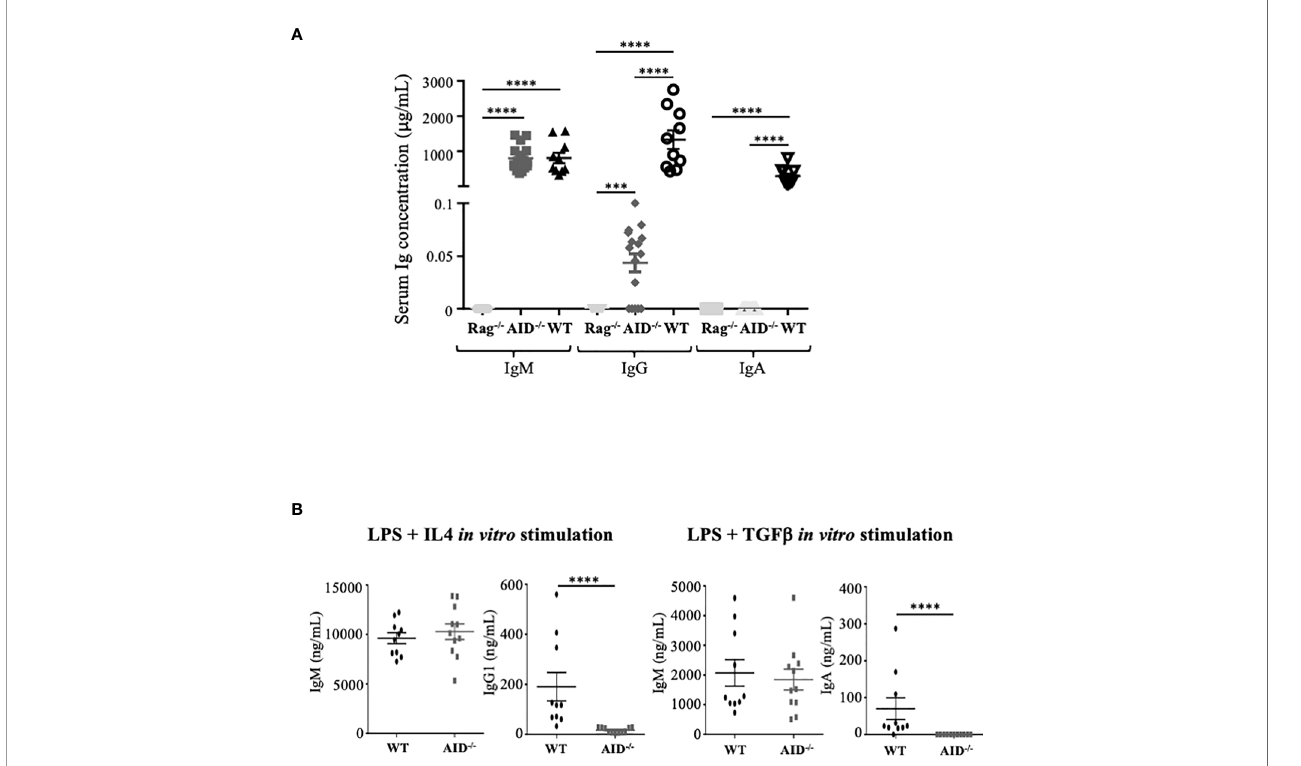
FIGURE 1 | Ig secretion by activation-induced deaminase (AID)-de fi cient mice. (A) Basal serum level of Ig in non-immunized mice. (B) In vitro secretion of Ig in B- cells from wild-type (WT) and AID-de fi cient mice stimulated for 4 days with lipopolysaccharide and IL-4 (left) or with LPS+TGF b (right). The supernatants were quanti fi ed by ELISA for IgM, IgG1, and IgA. The data represent mean concentrations ± SEM from two independent experiments with at least three WT and fi ve AID- de fi cient mice. Mann – Whitney test was used for signi fi cance. ****p <